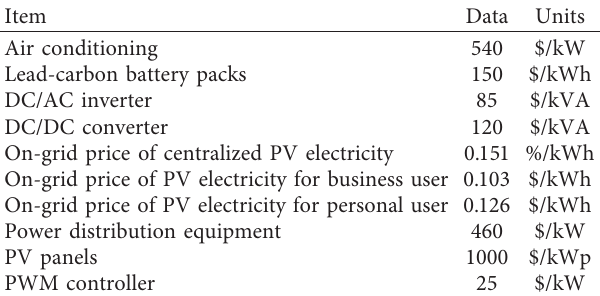
Table 2: Summary of cost of different equipment [29].